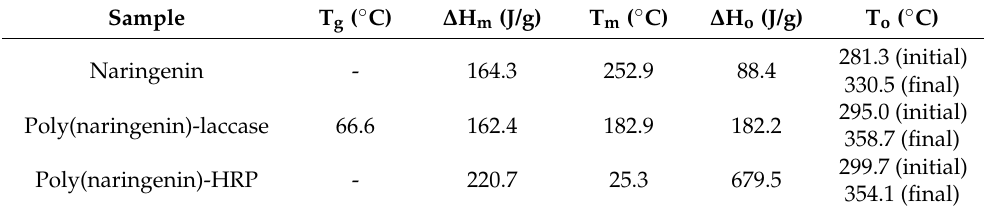
Table 4. DSC analysis of naringenin poly(naringenin)-laccase and poly(naringenin)-HRP.